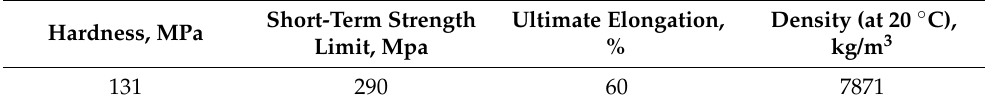
Table 2. Mechanical properties of the 08kp steel.